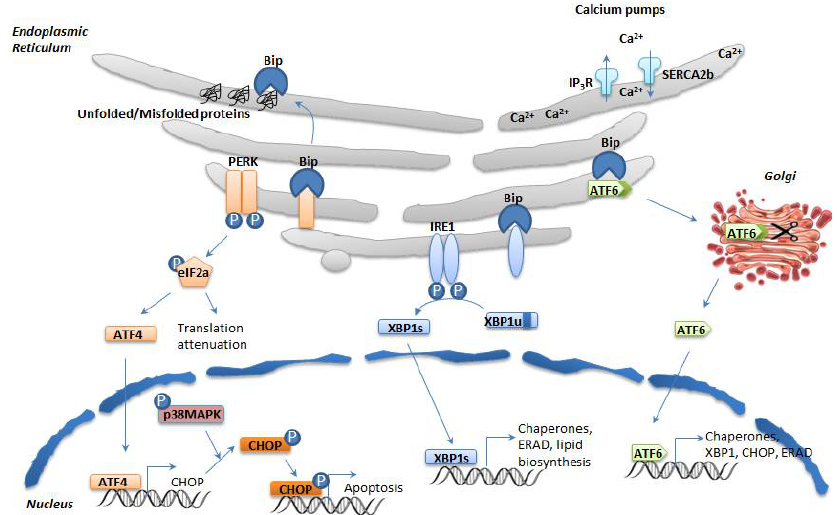
Figure 1. ER stress and the UPR. IP3R receptor and calcium pump SERCA are responsible for the efflux and influx of calcium in ER, respectively. Intracellular calcium dysregulation induces ER stress. ER stress induces the UPR. Unfolded or misfolded proteins are recognized by Bip, which then releases itself from PERK, IRE1, and ATF6, leading to their activation. The activation of PERK involves its homodimer formation and autophorsphorylation. It subsequently phosphorylates eIF2α, which in turn attenuates general translation but facilitates the translation of ATF4, thus increasing its protein level. ATF4 is a transcription factor that activates the transcription of CHOP. Phosphorylated p38 MAPK phosphorylates CHOP, which then triggers the transcription of apoptotic genes. Similar to PERK, IRE1 α activates after the formation and autophosphorylation of IRE1 homodimers. This activates IRE1α RNase activity. IRE1α then splices Xbp1 , removing 26 nucleotides from its transcript. Then, the XBP1s spliced form of XBP1 acts as a transcription factor for chaperones, as well as genes involved in ERAD and lipid biosynthesis. ATF6 activation involves its release from Bip, and its translocation into the Golgi, where it undergoes cleavage by S1P/S2P proteases. This allows its nuclear translocation and subsequent transcriptional activation of chaperones, XBP1, CHOP, and ERAD genes. Abbreviations: IP3R (inositol 1,4,5-trisphosphate(IP3R) receptor). IRE1α is the second player of the UPR. The activation of IRE1α after its dimerization and autophosphorylation triggers its endoribonuclease activity, which enables an unconventional splicing